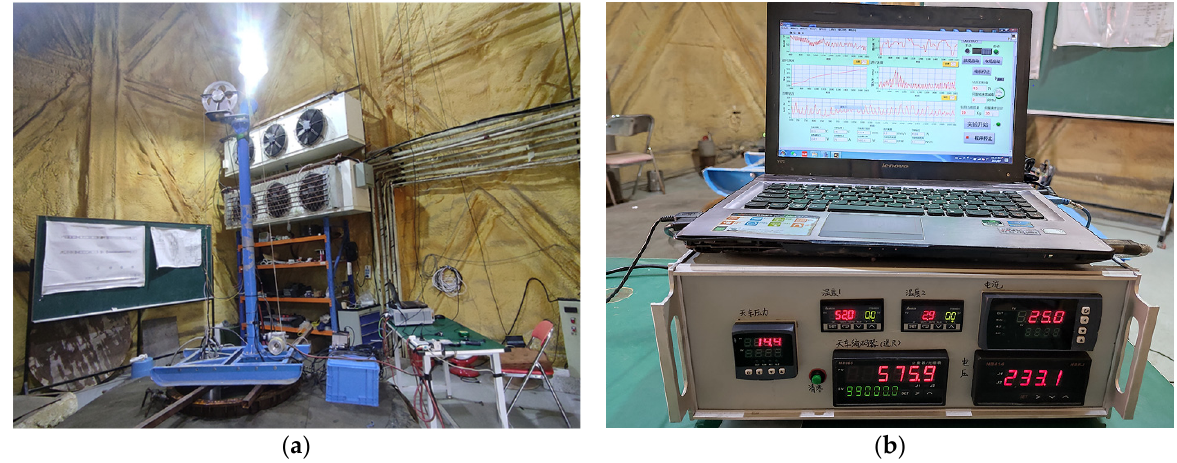
Figure 3. Overview of the experimental platform ( a ) and the control system ( b ).